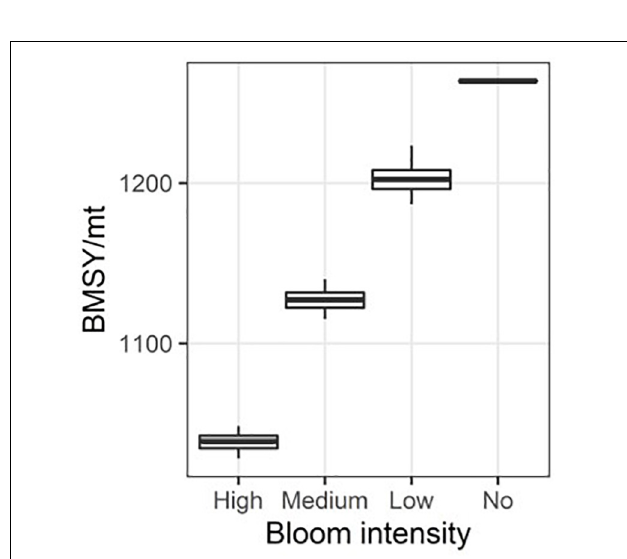
FIGURE 7 | The distribution of B MSY under different green tide bloom